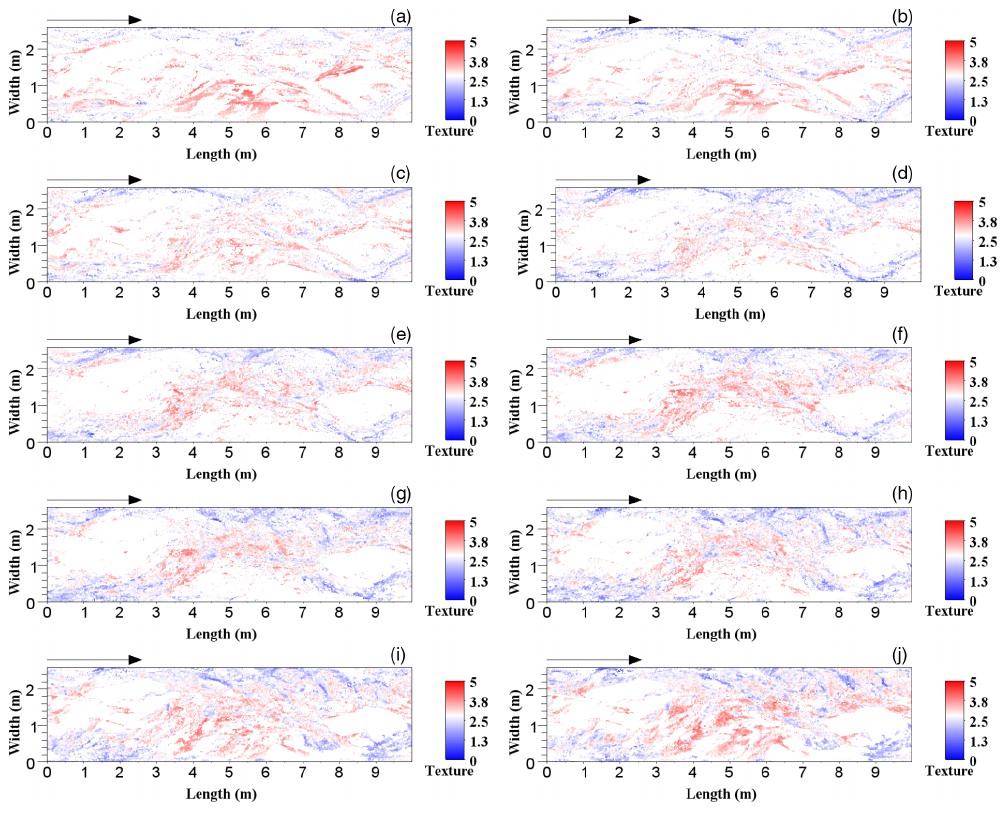
Figure 8. Equivalent texture maps: layer 1 (a) , layer 2 (b) , layer 3 (c) , layer 4 (d) , layer 5 (e) , layer 6 (f) , layer 7 (g) , layer 8 (h) , layer 9 (i) , and layer 10 (j) . The white part of the color scale is centered around the median value (2.7) of the distribution combined.